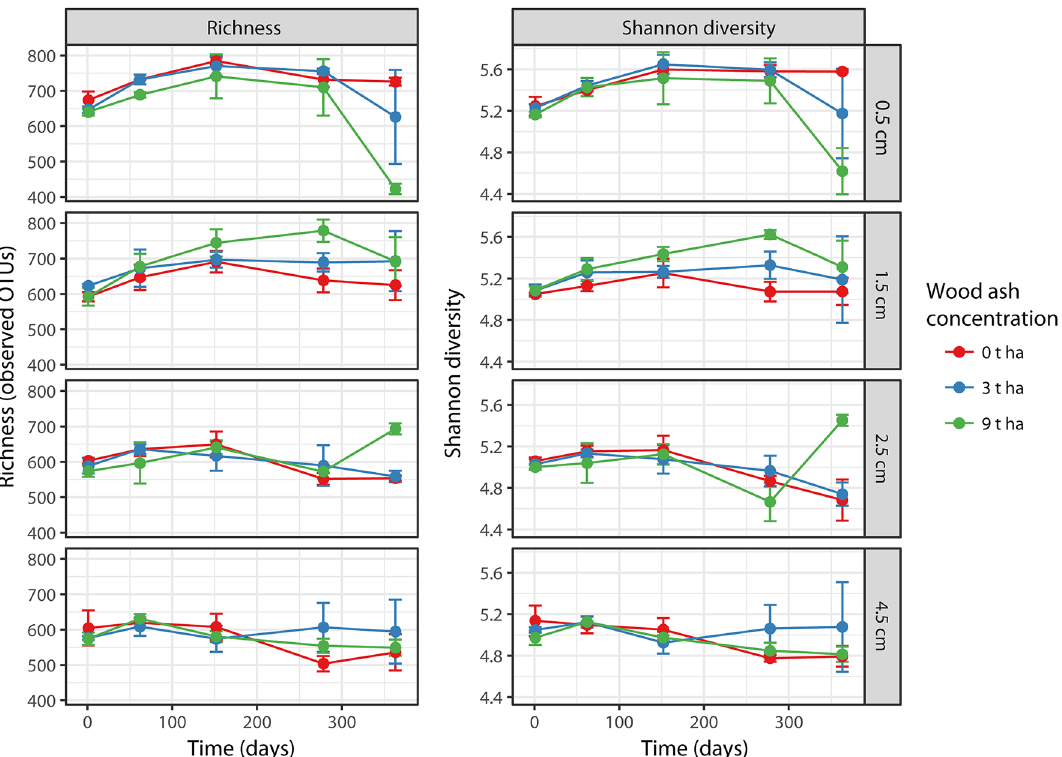
Figure 1. Prokaryotic richness (observed OTUs) and Shannon diversity across wood ash concentrations, soil depth and time after wood ash application. Error bars represent standard errors (n = 2 or 3). Figure was created in R v. 1.0.153 (www.R-proje ct.org) and GIMP v. 2.8.22 (https